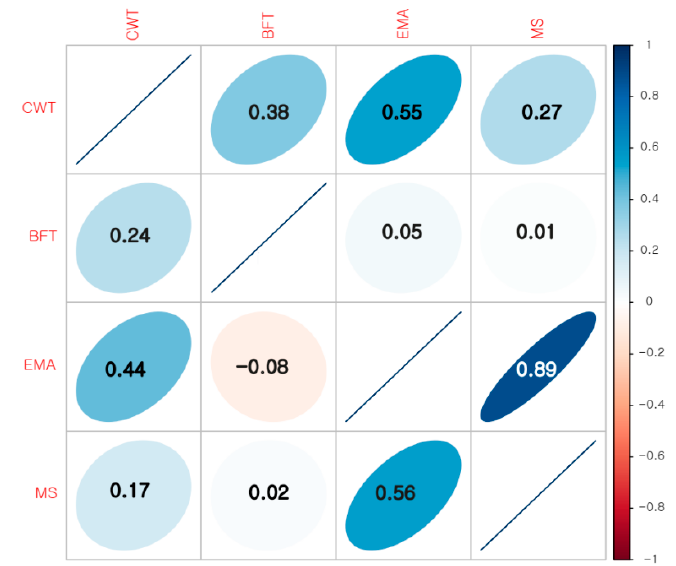
Figure 1. Phenotypic (upper diagonal) and genetic (lower diagonal) correlation among carcass traits in Hanwoo. The genetic correlation was calculated using bivariate reml in GCTA. The colors represent the strength of the correlation given in the scale next to the plot.